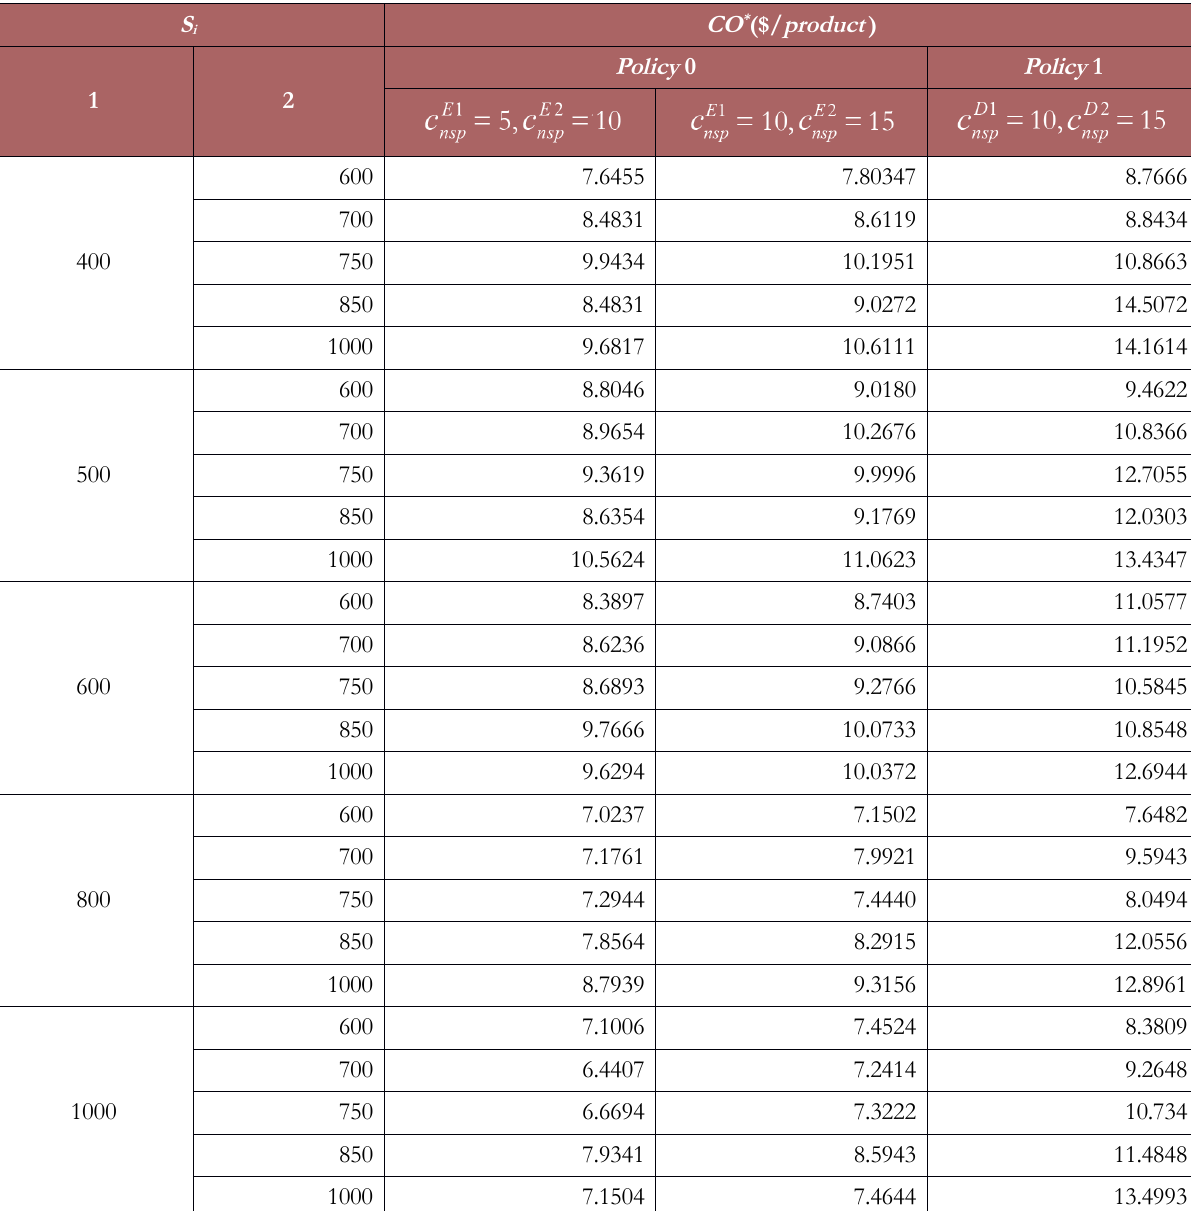
Table 5. CO * of two policies with different S